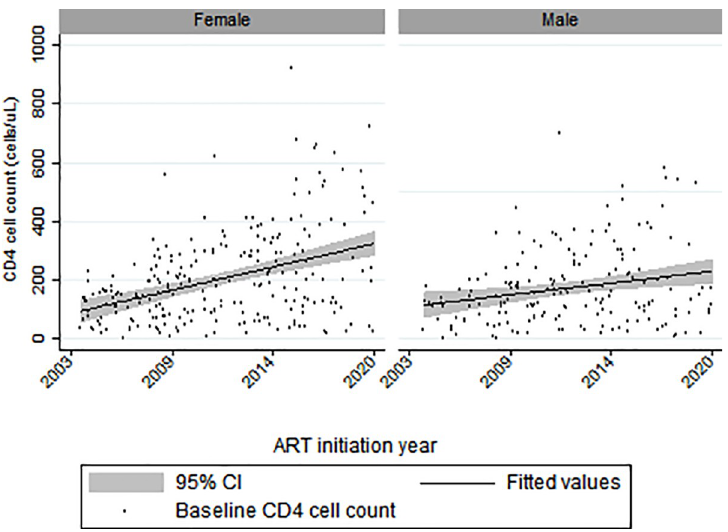
Fig 1. Baseline CD4 count distribution over ART initiation years by sex (two records with CD4 count > 1000 cells/ μ L omitted in the